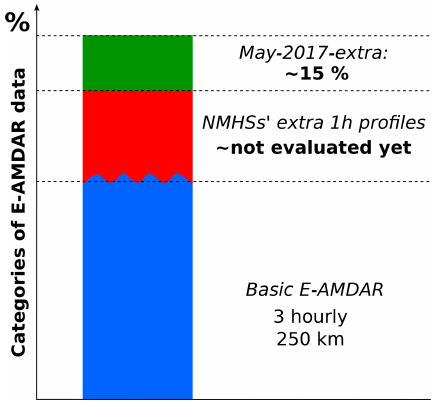
Figure 3. Diagram of the proportion of May-2017-extra observa- tions with respect to the other categories of E-AMDAR data. The exact proportion of the additional data bought by NMHSs (France, UK, Germany) in the AROME-France system is not known